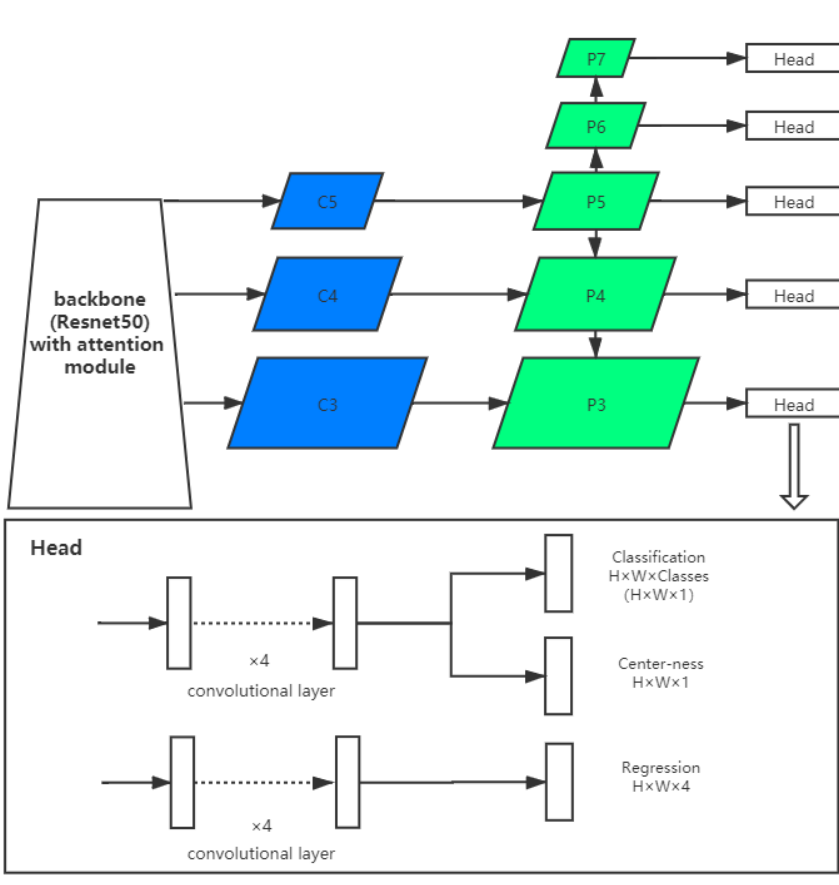
Figure 4. The structure of the Fully Convolutional One-Stage (FCOS) with attention